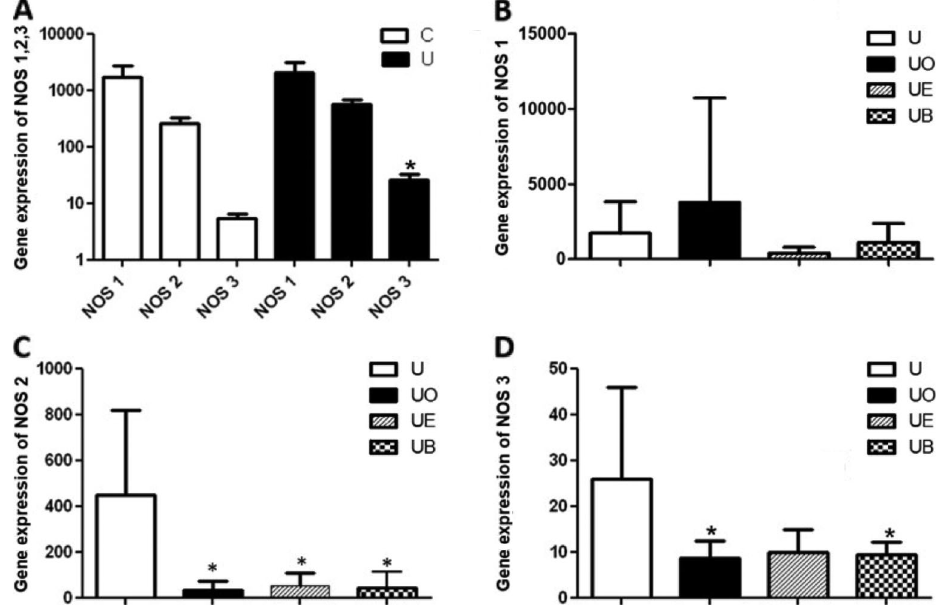
Figure 7. Gene expression of nitric oxide synthases. A , Expression of NOS1, 2, 3 in urethane-injected mice (U) was signi fi cantly higher than in control mice (C) (*P o 0.05). B , There was no signi fi cant difference in the gene expression of NOS1 in the study groups. C , Expression of NOS2 in urethane-injected mice was higher than in antioxidant supplemented mice, *P o 0.05, pequi oil group (UO), pequi ethanolic extract group (UE), and beta-carotene group (UB) vs urethane-injected group (U). D , Expression of NOS3 in mice supplemented with pequi oil and beta-carotene was lower than in urethane-injected mice, *P o 0.05, U vs UO and UB. Data are reported as means ± SD in urethane-injected and control mice (n=5) and urethane-injected and supplemented mice (n=10). Groups were compared using the ANOVA and the t-